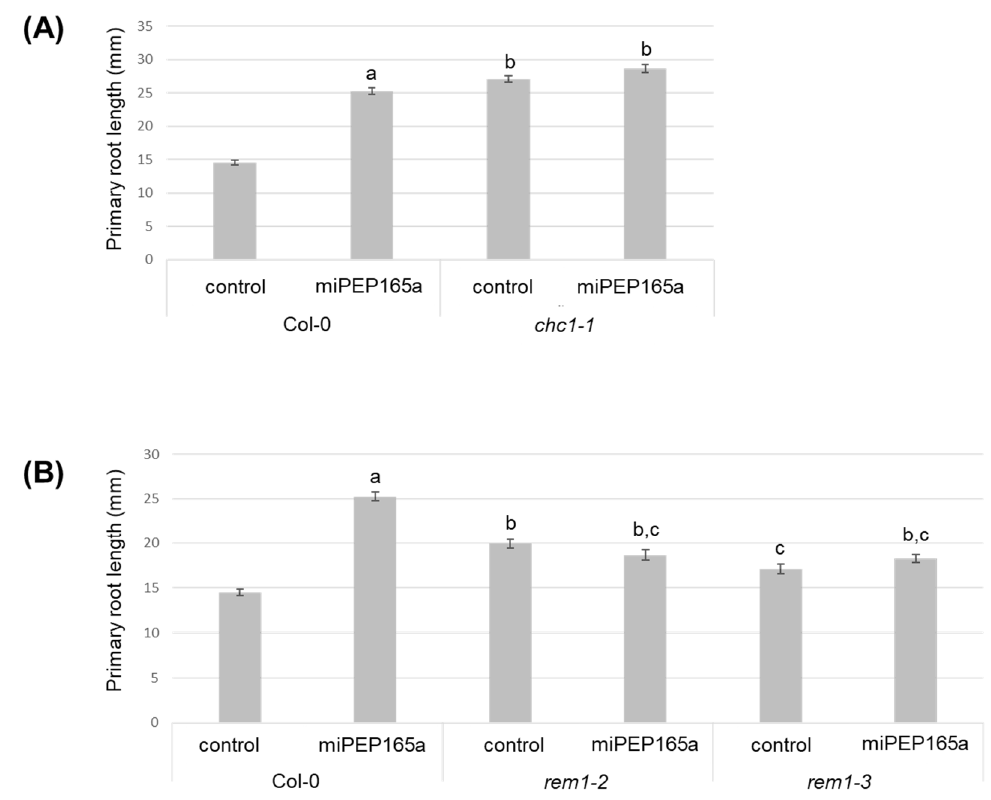
Figure 6. MiPEP165a-mediated root growth induction involves clathrin and remorin proteins. Measurement of the primary root length in chc1-1 ( A ) and remorin ( rem1-2 and rem1-3 ) mutants ( B ) after water (control) or miPEP165a (100 µM) treatment. The error bars indicate SEM of at least three biological replicates (n > 110 seedlings) and statistical analyses were performed using a t-test (a–c, p < 0.01).